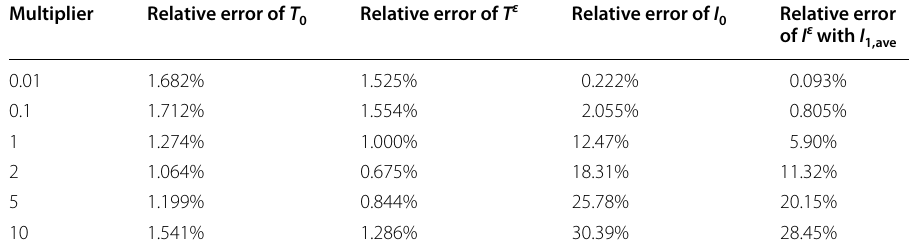
Table 4 Results of the multiscale simulations with different multipliers of the absorption and scattering coefficients